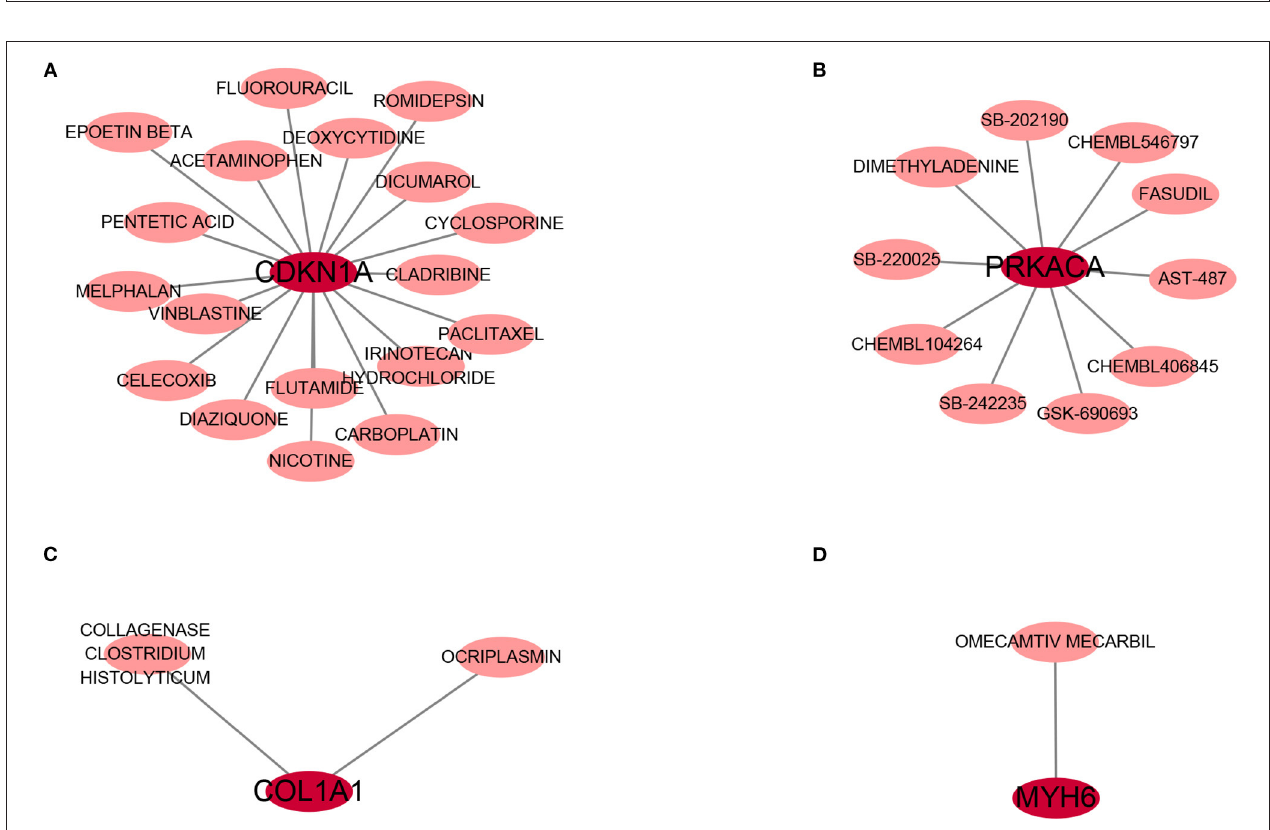
FIGURE 8 | corresponding selected features of each fold. (C) ROC curve analysis of the 7-gene-based model in merged data matrix of five datasets (training set). (D) ROC curve analysis of the 7-gene-based model in GSE17800(validation set). (E) Correlation heat map of risks genes and clinicopathological features in datasets GSE17800. The depth of the color represents the strength of the correlation; red represents a positive correlation, blue represents a negative correlation. The “x” means irrelevance. Correlation analysis of left ventricular ejection fraction (LVEF) and (F) MYH6, (G) ANKRD1, (H) PRELP, (I) CDKN1A and (J) COL1A1.